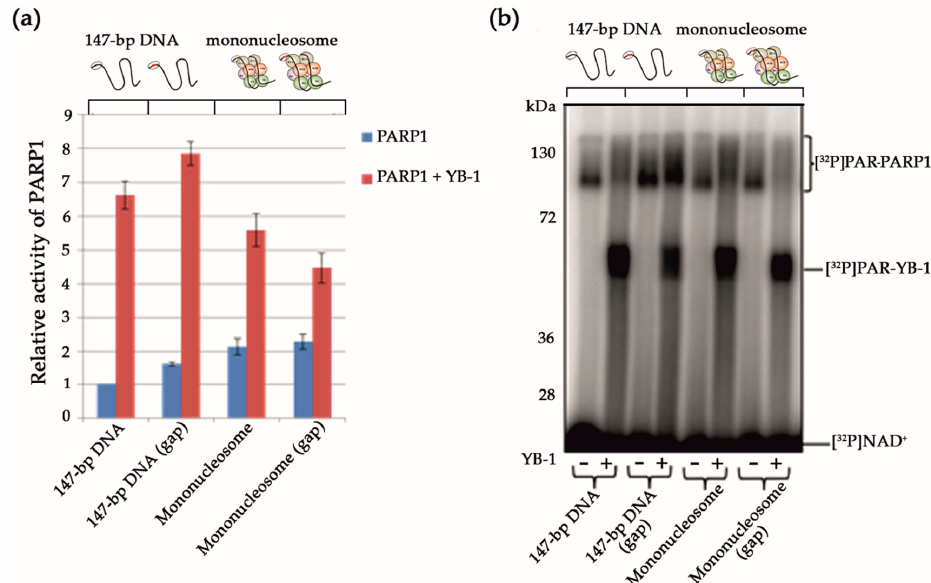
Figure 4. YB-1 stimulates PARP1 upon activation by a mononucleosome. ( a ) Quantification of PARP1 activity. PARP1 at 100 nM was incubated with 100 nM substrate and 4 µ M NAD + and [ 32 P]NAD (0.4 µ Ci) in the presence of 1600 nM YB-1 (where indicated). 32 P-PAR–modified proteins were TCA-precipitated and counted. The relative level of PAR synthesis was normalized to the level of PAR synthesis catalyzed by PARP1 alone for 60 min with 147 bp DNA. The experiments were conducted at least three times; the histogram shows the means ± SD of three independent experiments. ( b ) Assessment of the protein PARylation in the presence of 147 bp DNA or mononucleosome substrates and 4 µ M NAD + and [ 32 P]NAD (0.4 µ Ci) [ 32 P]NAD + by SDS-PAGE and phosphor imaging. The reaction mixtures contained 100 nM PARP1, 1600 nM YB-1 (where indicated), and 100 nM substrate.